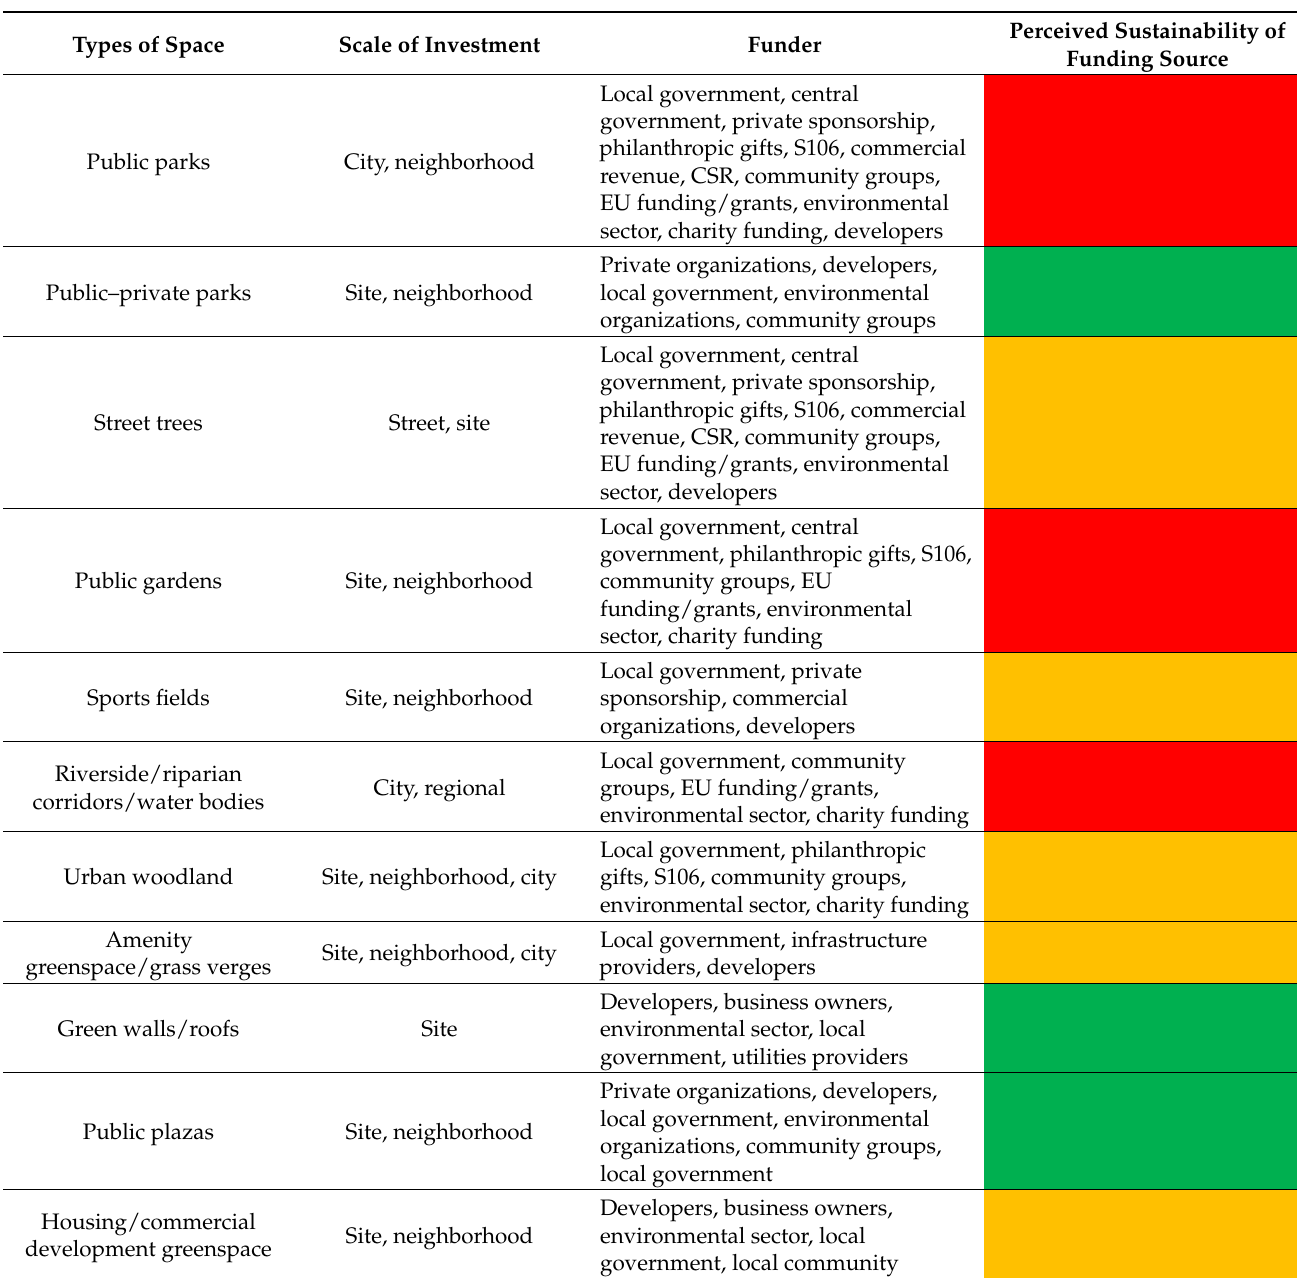
Table 2. Financing green